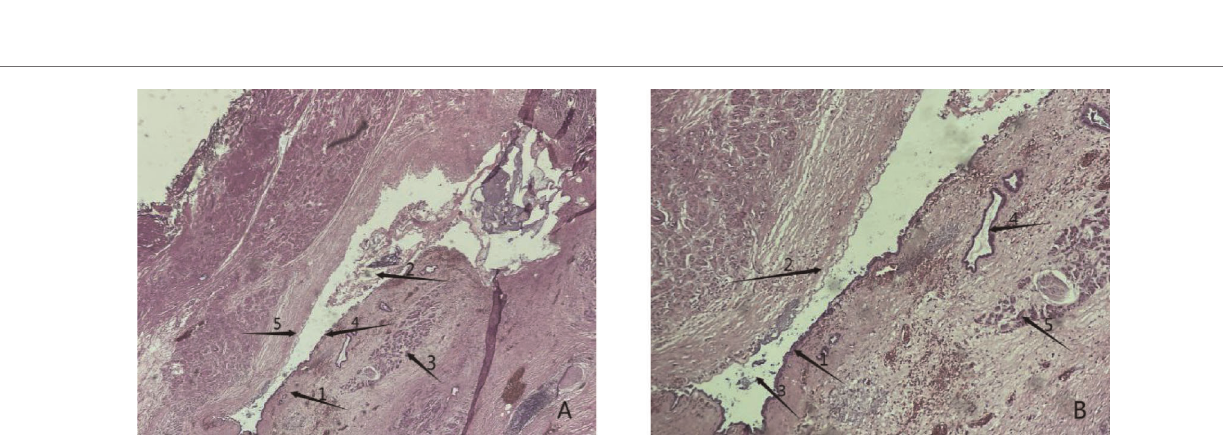
FIGURE 4 | Postoperative histopathology results. ( A ) Arrow 1 shows the capsule of the cyst wall, arrow 2 indicates staining for the secretory protein from the cystic cavity and pancreatic juice, indicating organization, arrow 3 indicates a normal pancreatic gland structure, and arrow 4 indicates a normal residual epithelioid structure in the process of epithelial shedding (40× magni fi cation). ( B ) Arrow 1 shows a normal residual epithelioid structure, arrow 2 shows epithelial detachment of the pancreas, arrow 3 shows the cystic cavity and its secreted proteins, pancreatic fl uid and other tissues, arrow 4 shows a normal pancreatic duct structure, and arrow 5 shows a normal pancreatic gland structure (100× magni fi